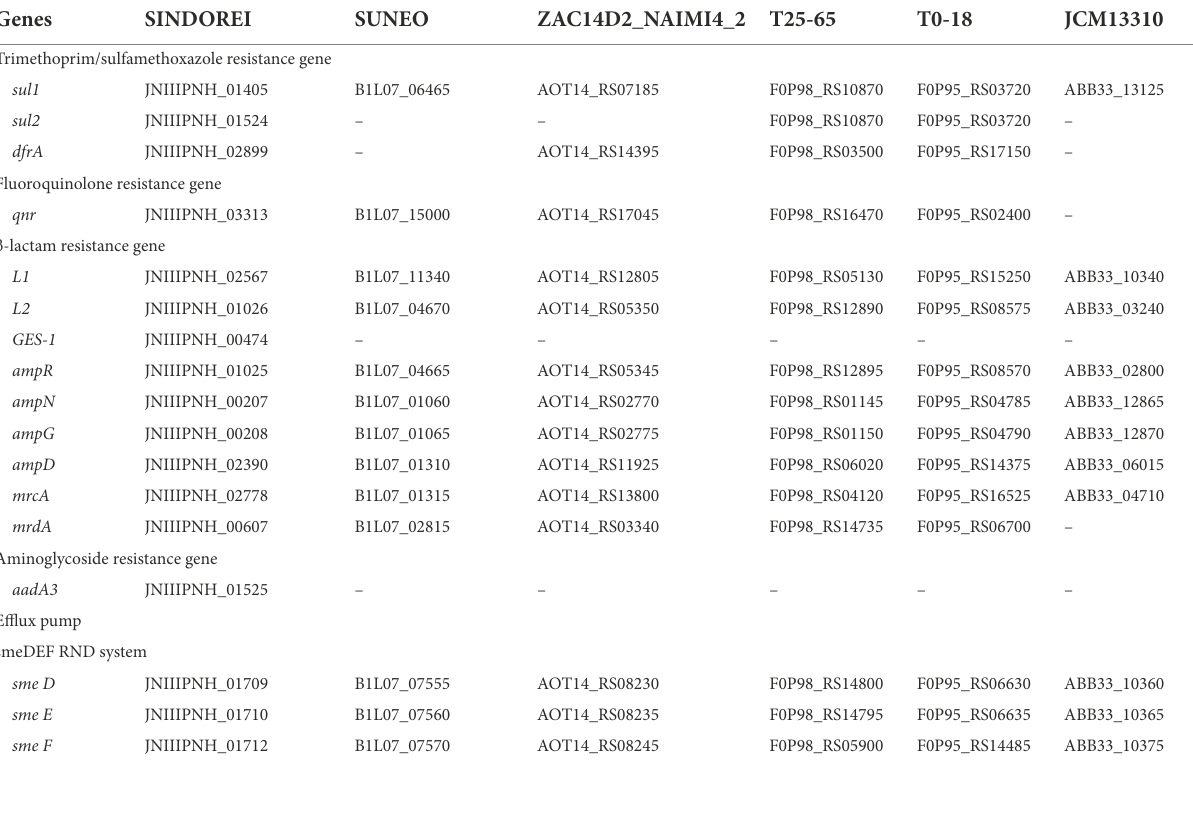
TABLE 4 The antibiotic resistance genes among the Stenotrophomonas acidaminiphila